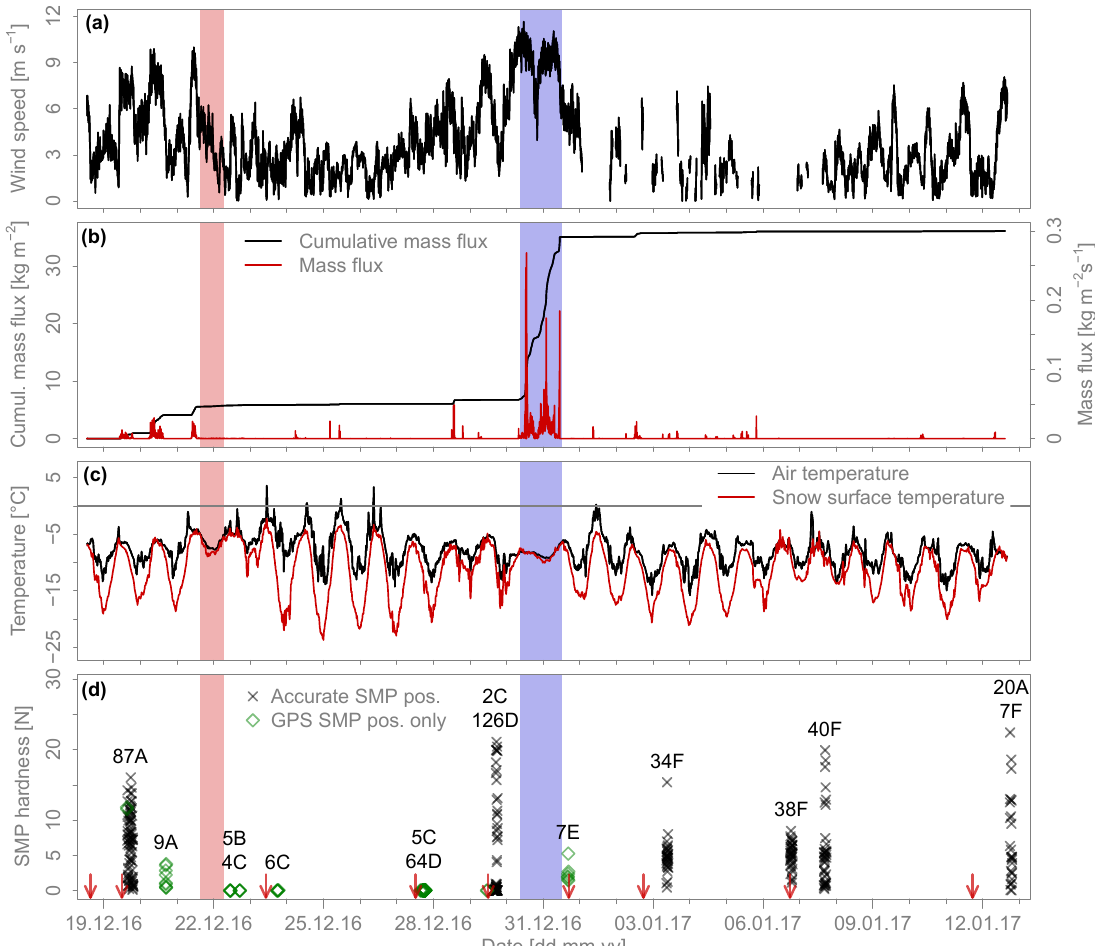
Figure 4. Overview of the observed snowfall and drifting snow event. Panel (a) shows the averaged 2m wind speed, (b) the (cumulative) drifting snow mass flux, (c) the air temperature and the snow surface temperature, and (d) the SMP hardness. Similar to Fig. 3, SMP measurements with an accurately known position are shown with black crosses and SMP measurements for which only the GPS position is available are shown with green diamonds. The codes (e.g. “87A”) indicate how many SMP measurements were acquired on that day and in which group in Fig. 3 they are located. On several days, SMP measurements were acquired in two different groups. The snowfall period (light red) and the main drifting snow period (light blue) are highlighted. The vertical red arrows in (d) show when TLS scans were